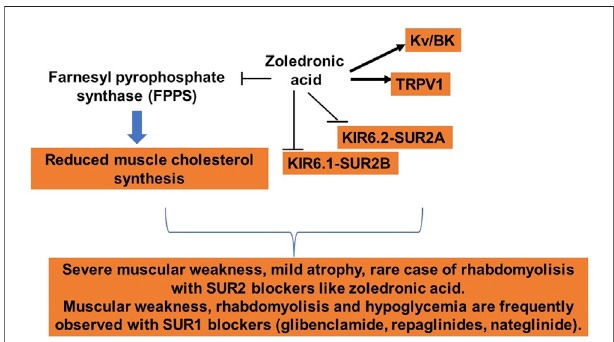
FIGURE 7 | Zoledronic acid actions in skeletal muscle. The drug inhibits the farnesyl pyrophosphate synthase leading to reduced cholesterol production, potentiates the TRPV1 and BK channels, and inhibits the KATP channelsmore speci fi cally thechannelcomposed bytheKir6.2-SUR2A, but also inhibit the Kir6.1-SUR2B channel located in the soleus muscle and the microvasculature.